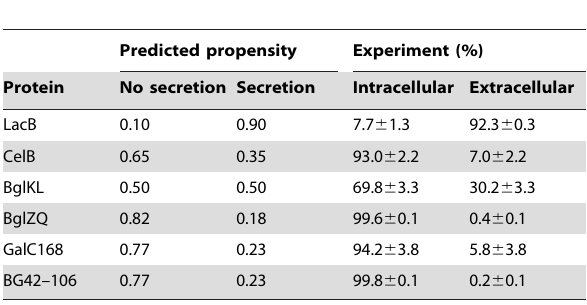
Table 2. Predicted propensity and the experimental results on the six b -galactosidase.